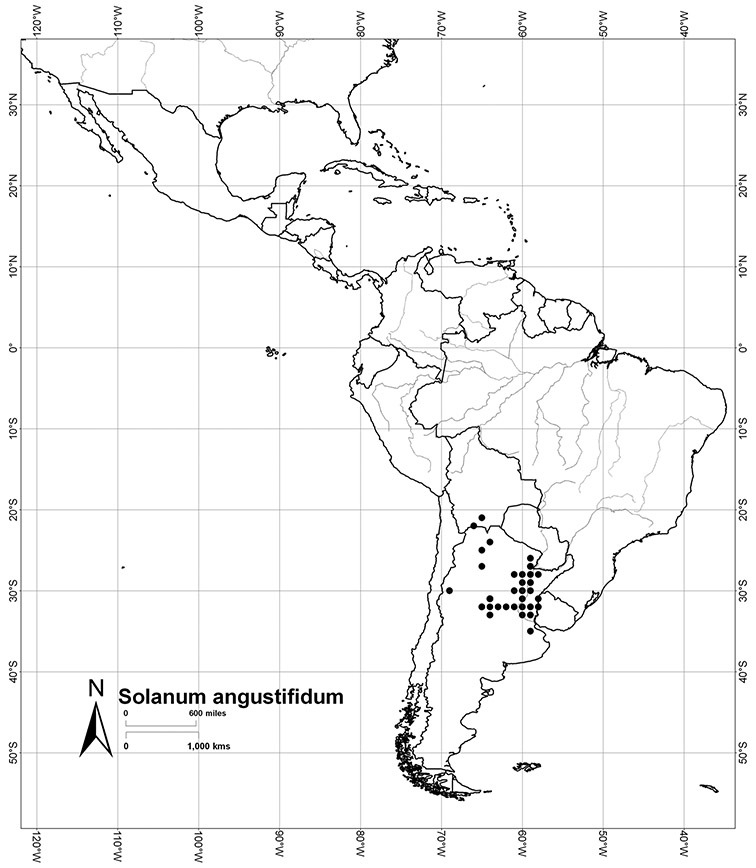
Distribution of Solanum angustifidum Bitter.